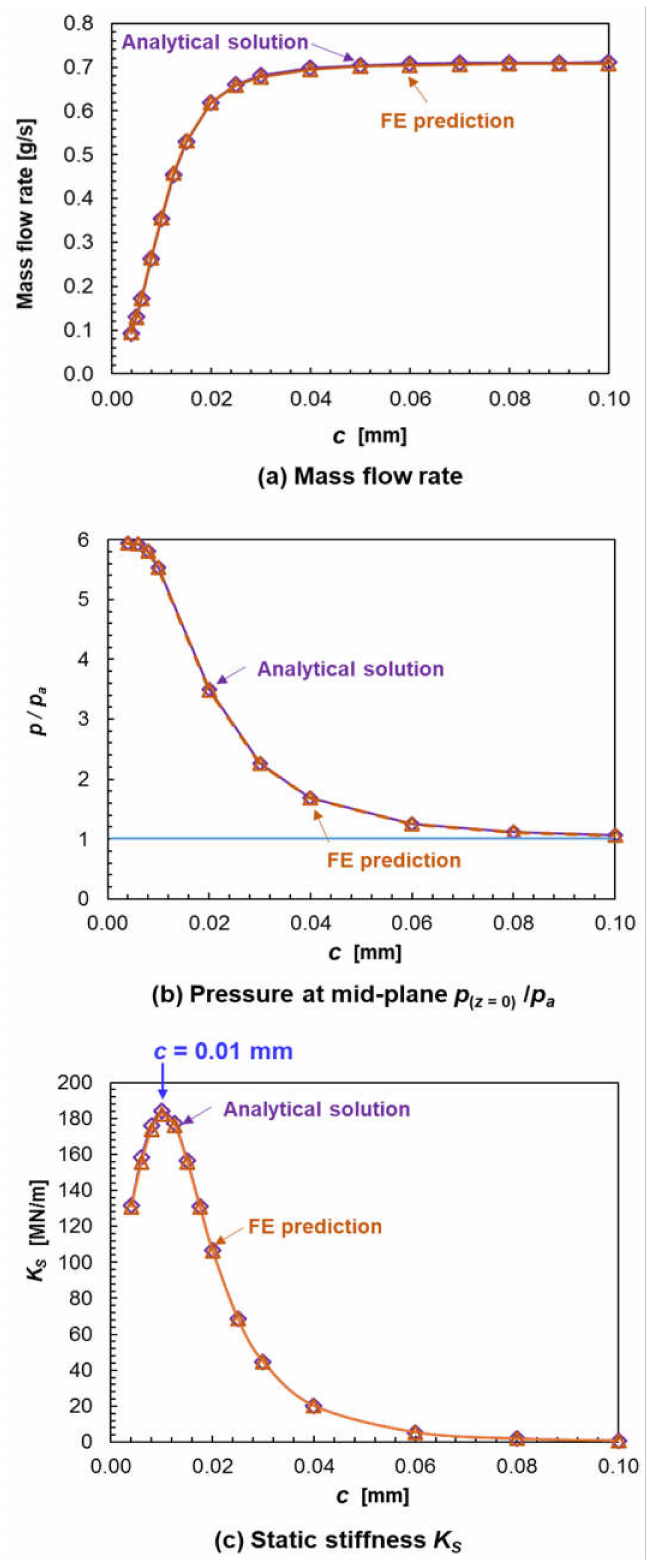
Figure 4. PGB mass flow, pressure at bearing mid-plane, and aerostatic stiffness vs. clearance ( c ); ( a ) Mass flow rate; ( b ) Pressure at mid-plane p ( z = 0) / p a ; ( c ) Static stiffness K S . Analytical and FE predictions. Air supply pressure p S = 6 bar. Aerostatic operation at e =